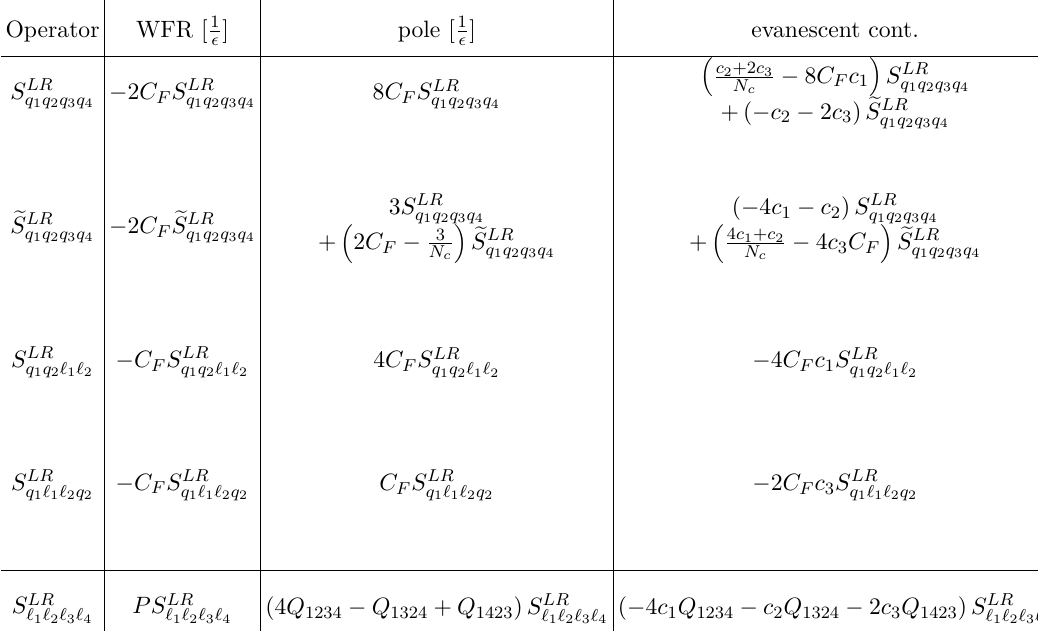
Table 12. Loop structure for P L ⊗ P R operators: the columns correspond to the divergent WFR contributions and vertex corrections as well as the finite contributions from evanescent operators, computed in the generalised BMU scheme. The first four rows result from QCD and are given in units of α s / (4 π ) whereas the last one is a QED correction given in units of α/ (4 π )